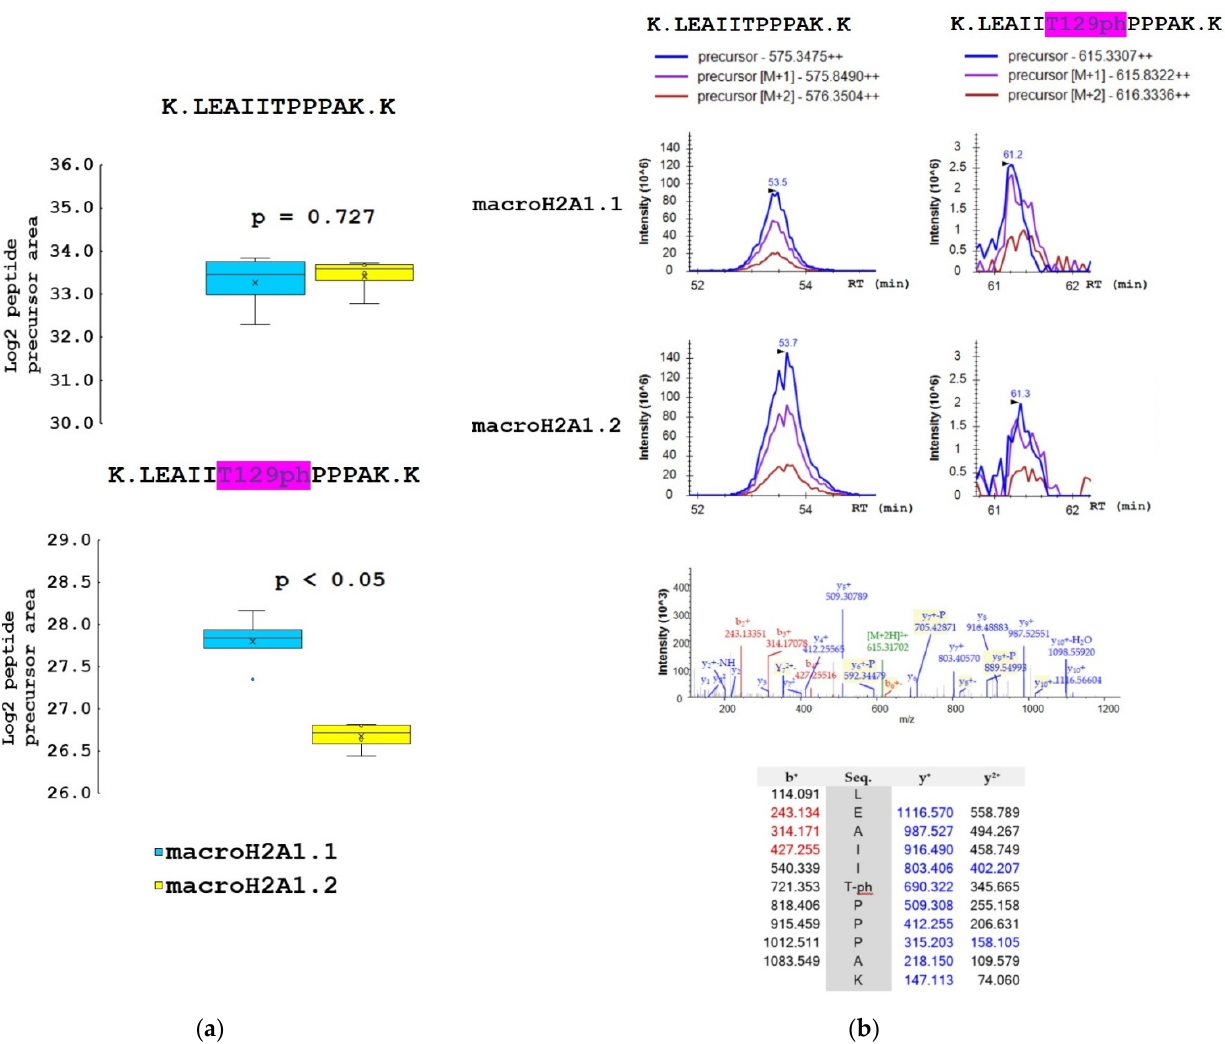
Figure 4. The proportion of T129ph mark on macroH2A1.1 and macroH2A1.2 protein isoforms in HepG2 cells. ( a ) Box ‐ plots of the relative abundance of phosphopeptides and corresponding non ‐ modified counterparts showing extremes, interquartile ranges, means, and medians (N = 4). Data were normalized to the sum of selected non ‐ modified peptides to eliminate the effect of different expression levels of the two isoforms during quantitative analyses. Differences between samples in normalized peptide abundances ≥ 1.5 ‐ fold at p < 0.05 were considered as significant. ( b ) Representative MS extracted ion chromatograms of K.LEAIITPPPAK.K with (m/z 615.331) and without phosphorylation at T129 (m/z 575.348), showing their abundance in macroH2A1.1 and macroH2A1.2 isoforms. Representative MS/MS spectrum produced from the precursor ion of m/z 615.331 and fragments of y ‐ and b ‐ series with the m/z values are shown.